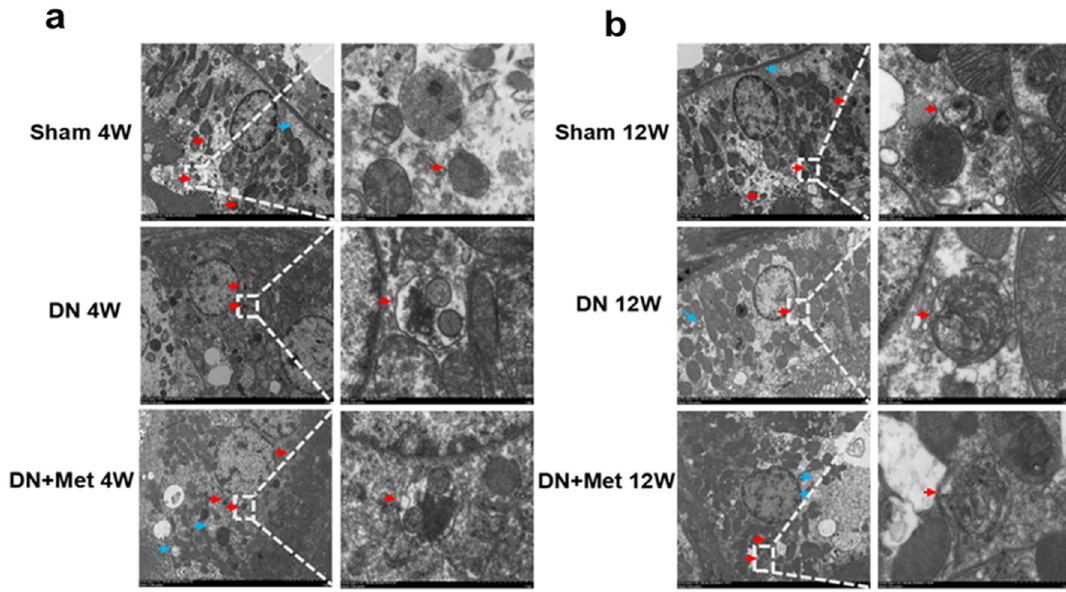
Figure 4. Effects of metformin on autophagy and autolysosome in DN kidneys. Autolysosomes were detected by transmission electron microscope at the 4-week molding ( a ) or 12-week molding ( b ). The blue arrow indicates autophagy, and the red arrow indicates autolysosome. Scale bar represents 5 μm (left) and 1 μm (right) respectively. 4W: 4-week; 12W: 12-week; Met: